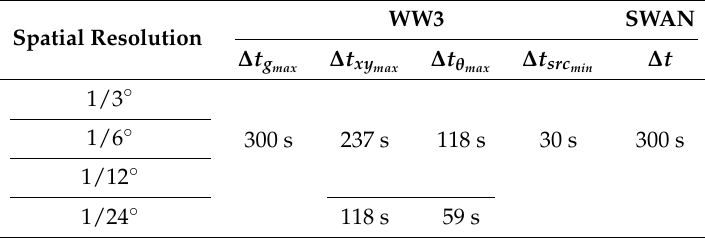
Figure 3. Configuration of model grids of different resolutions and storm tracks are shown in the southeast part of the computational domain. The storm tracks in four different directions are shown in orange. Size and color of the grid points denote the resolution. Red, magenta, black and cyan represent grid points in 1/3 ◦ , 1/6 ◦ , 1/12 ◦ and 1/24 ◦ resolutions, respectively. The angle of tracks are 180 ◦ , 165 ◦ , 150 ◦ , and 135 ◦ (0 ◦ at positive x -axis). Table 3. Spatial resolutions and corresponding numerical time steps set in two